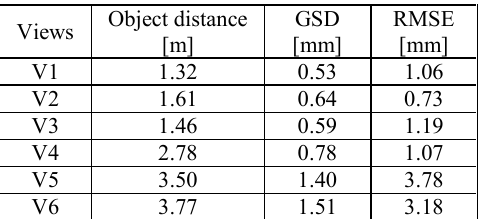
Table 2. Object distance, GSD and RMSE of the reference points after calibration.